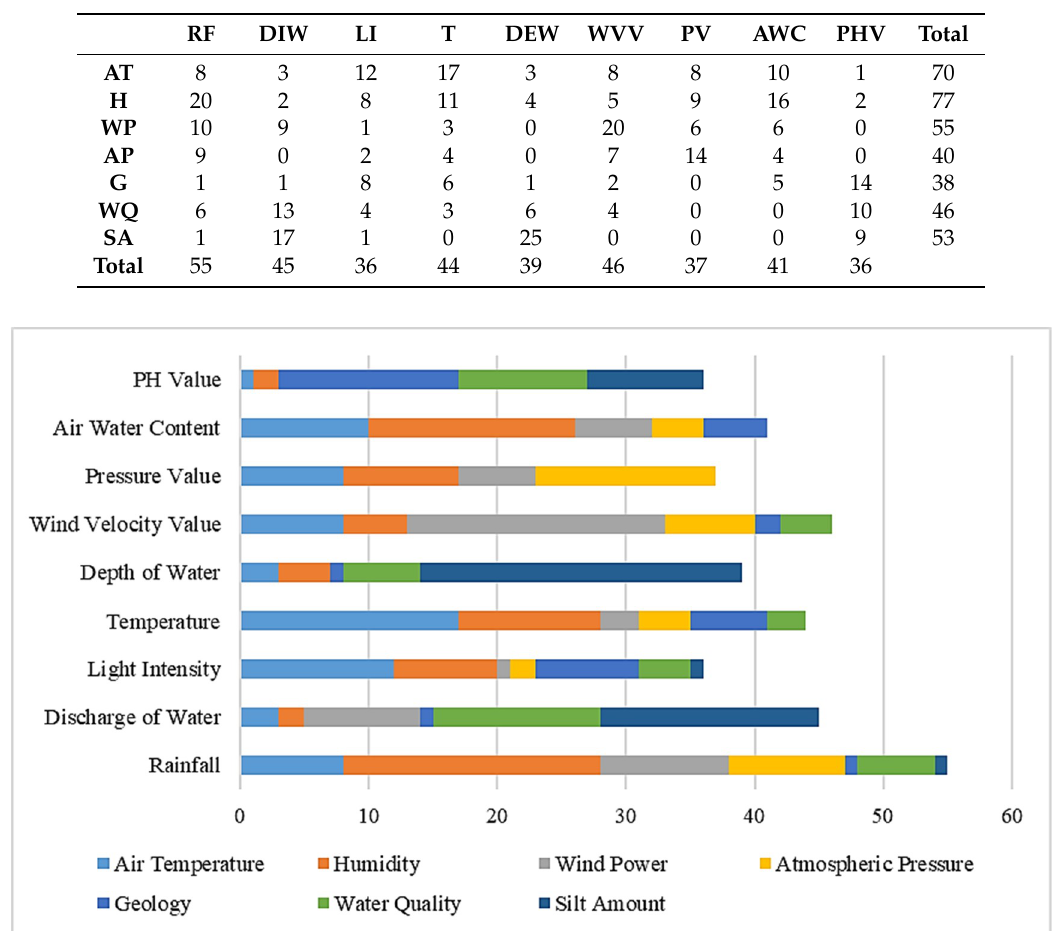
Figure 1. Attribute intersection distribution of random forest division. Table 4. Attribute intersection distribution of random forest division.